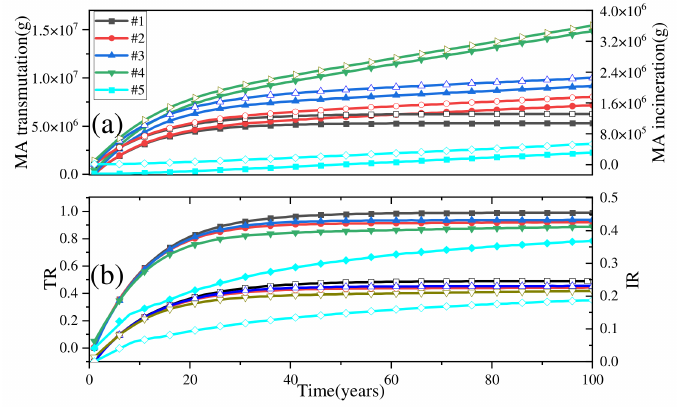
Figure 10. Evolution of MA transmutation (solid dot lines), incineration (empty dot lines) ( a ), TR (solid dot lines), and IR (empty dot lines) ( b